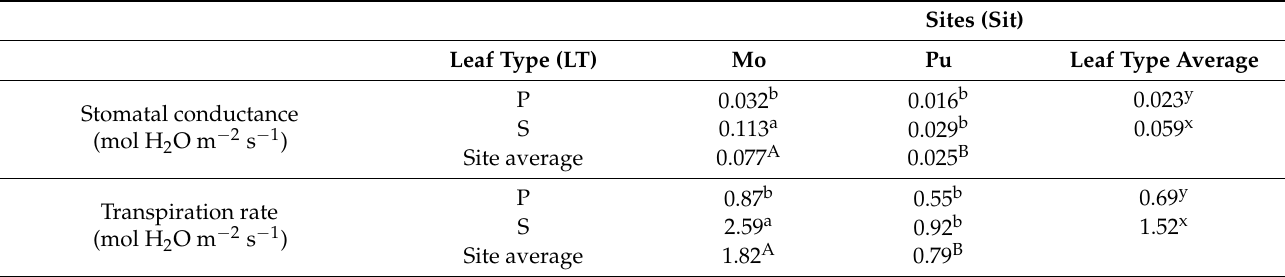
Table 2. Leaf-level stomatal conductance and transpiration rate of different leaf types (P: petiolate; S: sessile) of Salvia ceratophylloides individuals of two sites (Mosorrofa, Mo; Puzzi, Pu) measured at a light intensity of 200 µ mol m − 2 s − 1 . Different lower-case letters represent significant differences at p < 0.05 among the average within the column (Tukey’s test). Different capital case letters represent statistically significant differences among the means along the rows ( p < 0.05, Tukey’s